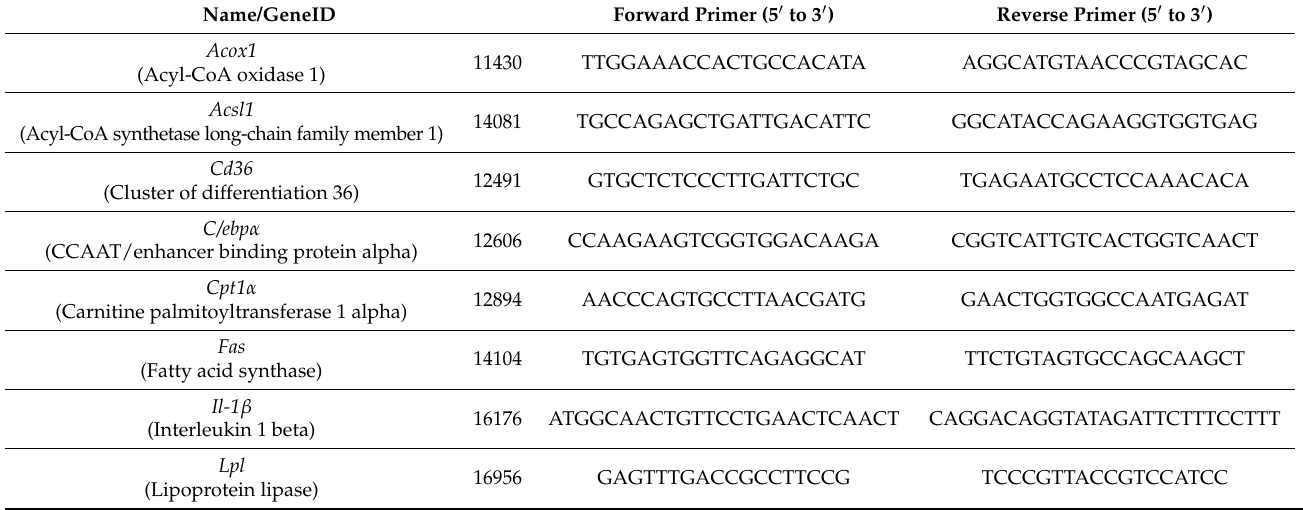
Table 2. Primer sequences for quantitative real-time